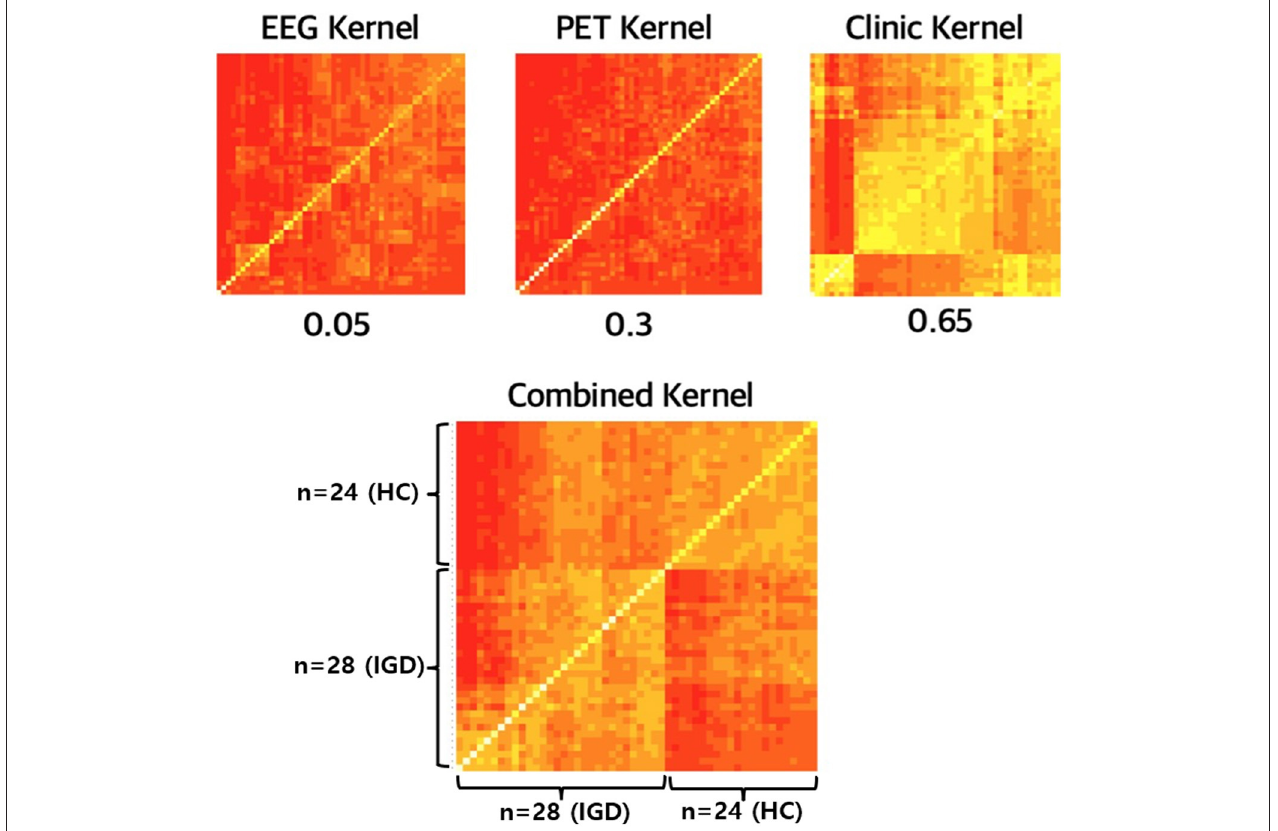
FIGURE 6 | The kernel matrices for EEG, PET, and clinical features and its combined kernel.